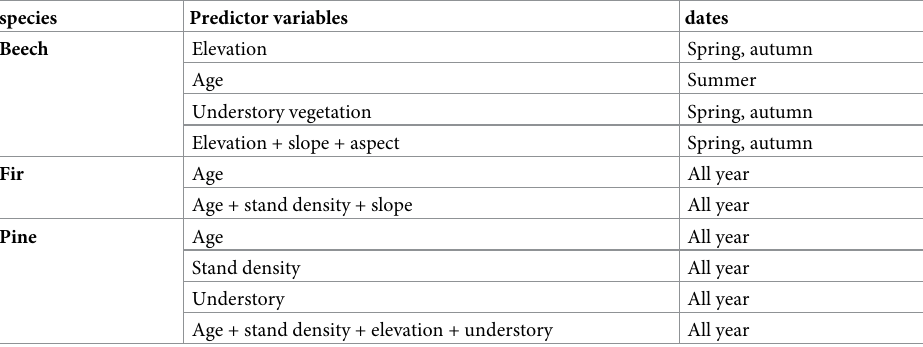
Table 2. Single and multiple GAMs fitted in this